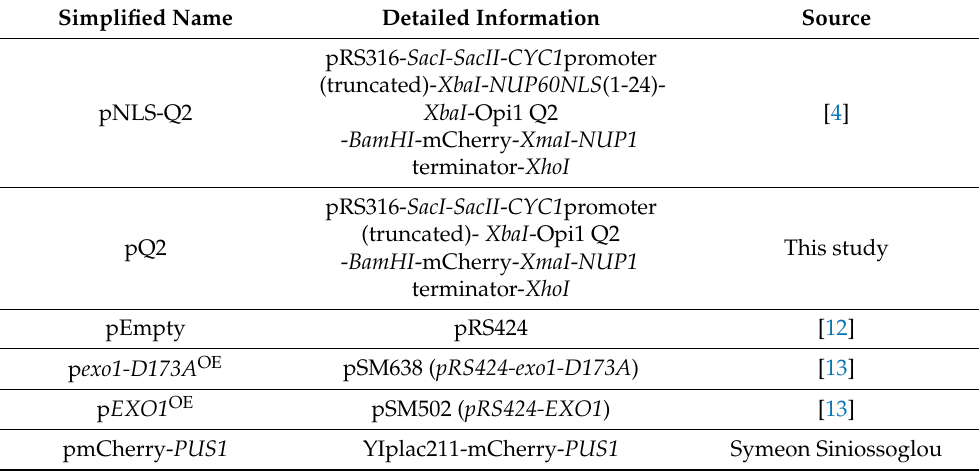
Table 2. Plasmids used in this